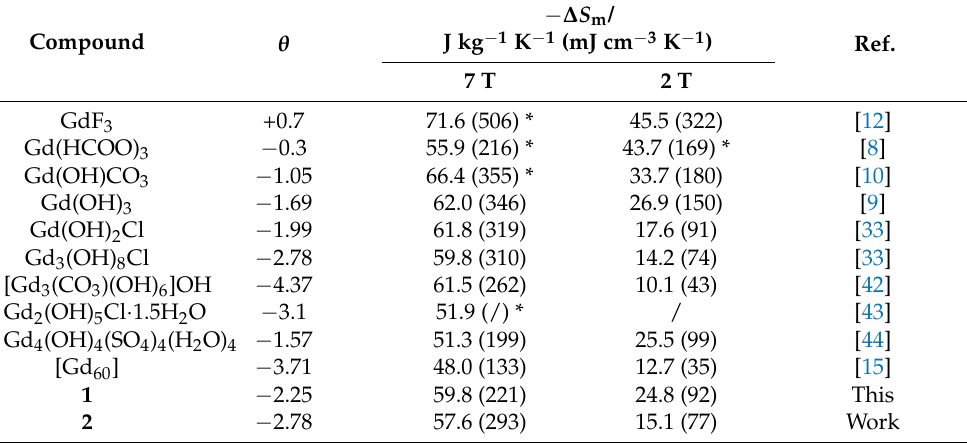
Table 1. Weiss constants and magnetic entropy changes for selected Gd-based magnetocaloric materials ( − ∆ S m